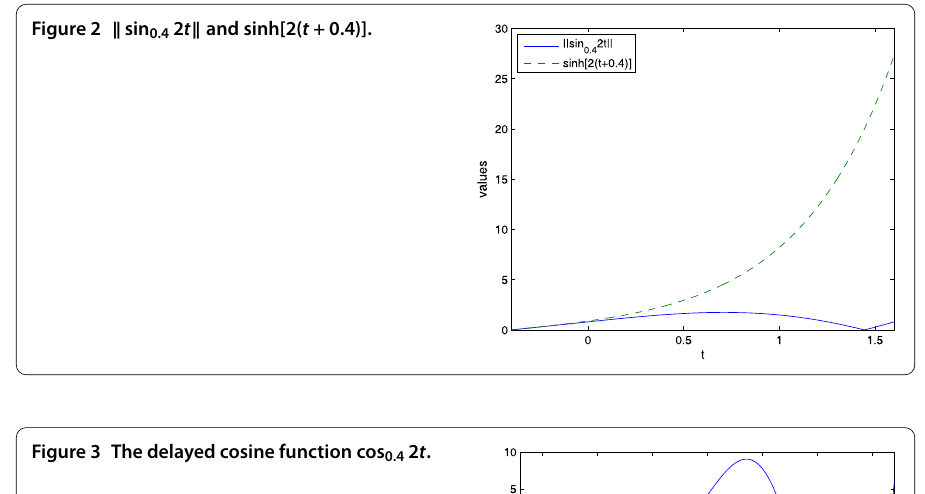
Figure 2 (cid:2) sin 0.4 2 t (cid:2) and sinh[2( t + 0.4)].